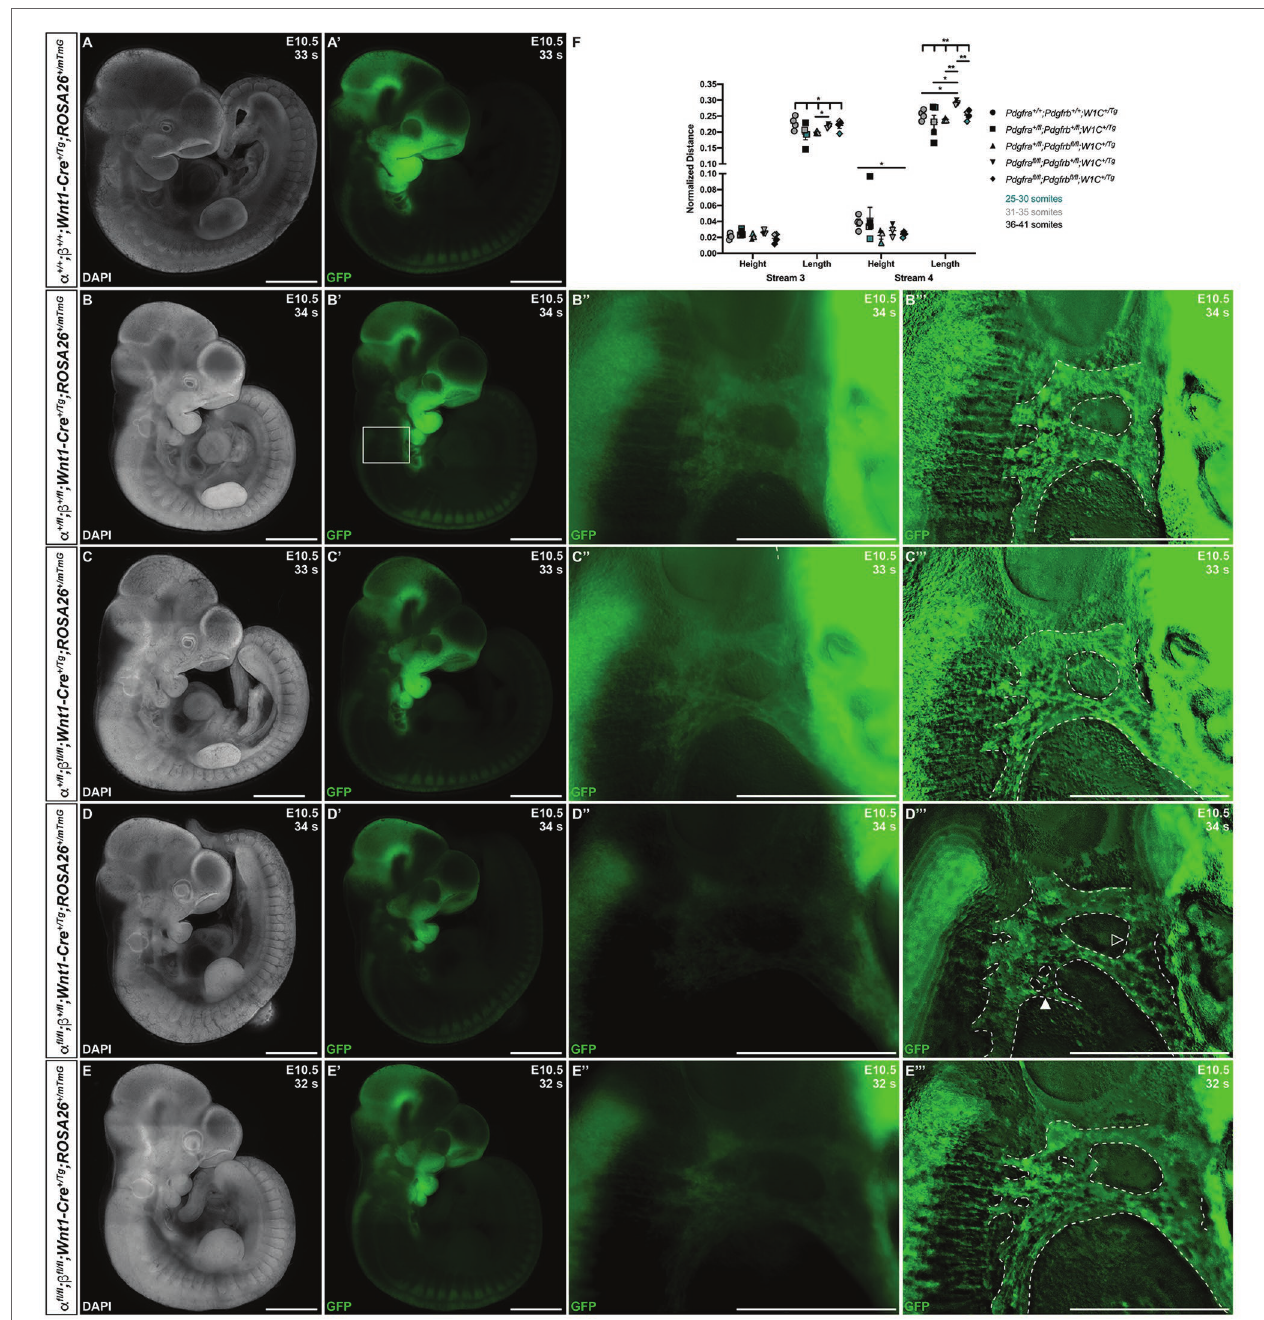
FIGURE 4 | Ablation of Pdgfra and Pdgfrb in the NCC lineage results in longer cNCC streams entering PA3 and PA4 at E10.5, with increased incidences of stream bifurcations and intermingling. (A–E ' ) Lateral, whole-mount fluorescence images of DAPI (A–E) and GFP (A ' –E ' ) expression across five genotypes at E10.5. (B '' –E ''' ) Zoomed-in images of GFP expression in cNCC streams (outlined by dotted lines) entering PA3 and PA4. Filled arrowhead indicates an example of a bifurcated cNCC stream. Unfilled arrowhead indicates an example of intermingling cNCC streams. (F) Scatter dot plot depicting the normalized anterior-posterior heights and dorsal-ventral lengths of cNCC streams entering PA3 and PA4 across five genotypes at E10.5. Data are presented as mean ± SEM. * p < 0.05; ** p < 0.01. Colors correspond to number of somite pairs in assayed embryos.